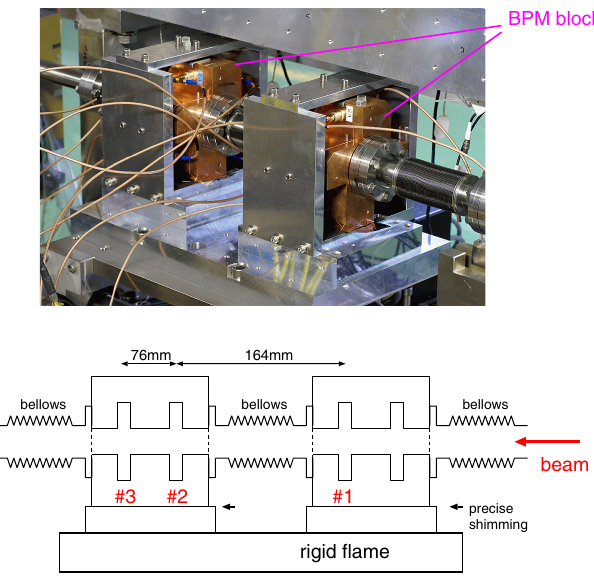
FIG. 6. (Color) BPM support system installed in the beam line. Two blocks were rigidly mounted in the system. The three cavities named 1, 2, and 3 were used in this test. Distances between cavities were 164 and 76 mm. They determine the geometrical factor that appears in the resolution analysis to be